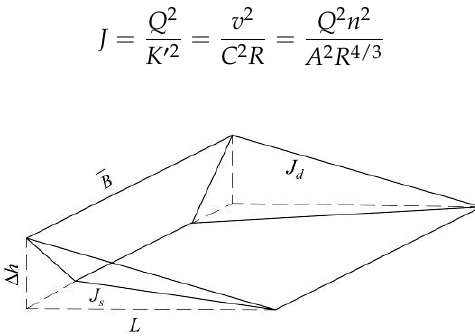
(Figure 3). For the artificial trapezoidal section canal pool, the hydraulic gradient J of the open channel steady gradient flow can be calculated by Equation (9).